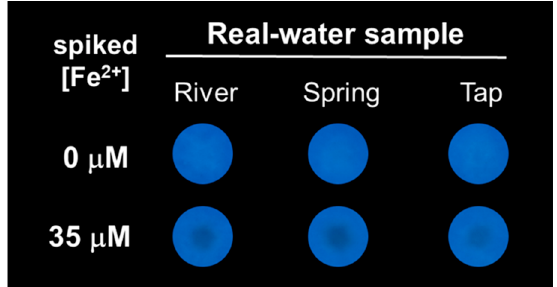
Figure 4. Photographic pictures of His-AuNCs-paper-based platform acquired during the Fe sensing assays (Fe 2+ spikes) from selected local water samples. The pictures were acquired under UV light excitation, 15 min after the real water samples with and without the 35 μ M Fe 2+ spikes were dropped. The His-AuNCs-paper spots were previously dried for 24 h.